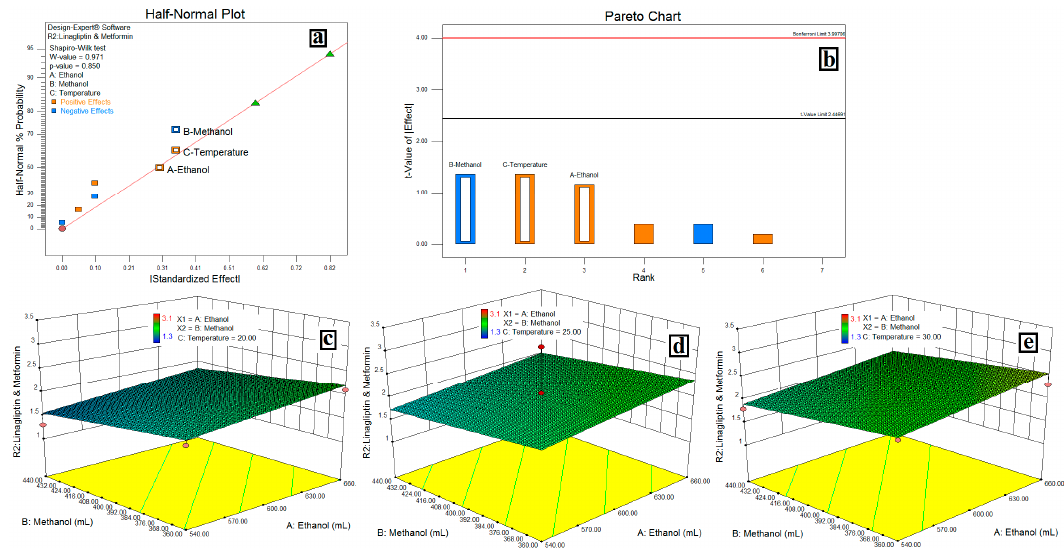
Figure 4. Relation between variables on resolution of LGP and MET HCl ( a ) Half-Normal Plot; ( b ) Pareto Chart; ( c , d and e ) 3D Plots showing the linear effect of temperature with volume of EtOH from mobile phase.